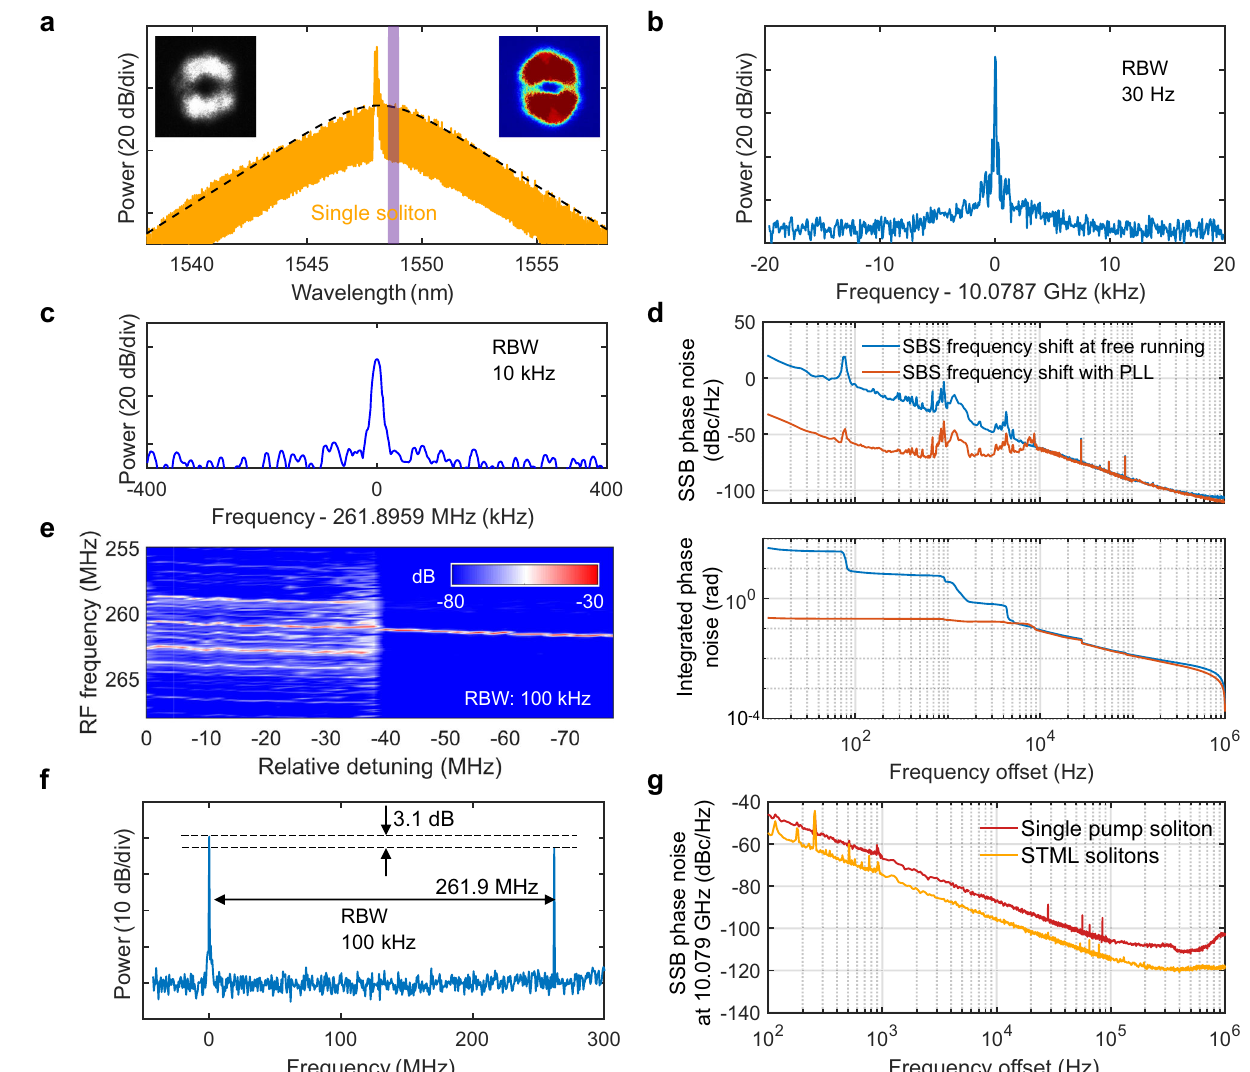
Fig. 3 | Spatiotemporally mode-locked DKS microcombs. a Optical spectrum of theSTMLDKS.Theblackdashedlineshowsthe fi ttedDKSspectralenvelope.Insets are the measured (grey) and rebuilt (colored) beam pro fi les. The rebuilt beam pro fi leisbasedonthesuperpositionofthecold-cavitypumpandSBLmodepro fi les in Fig. 1c with intensity difference of 3.1dB. The purple shaded area indicates the optical bandpass fi lter. b , c Clean and high-contrast RF beat notes of comb repe- tition rate and Δ f ceo , respectively. d SSB phase noise spectra (top) and integrated